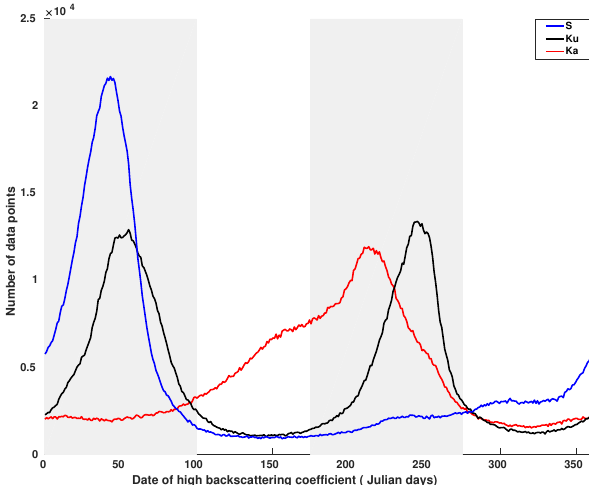
Figure 3. Histogram of the seasonal date of maximum backscatter- ing coefficient at the S (blue), Ku (black) and Ka (red) bands. The gray bars represent periods referred to as summer (January to April) and winter (June to September).